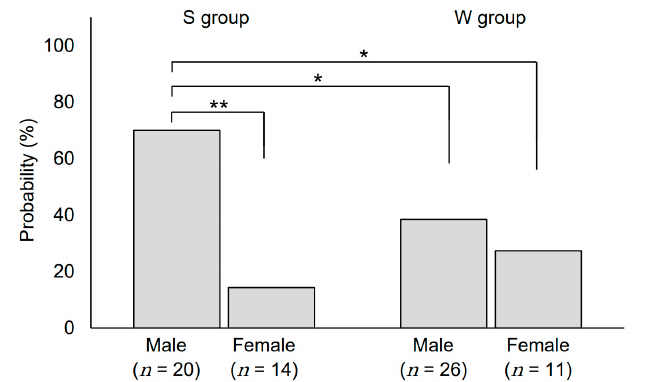
Figure 5. Incidence of grade 2 or higher acne-like rashes based on sex and season. Left, summer (S); right, winter (W). * p < 0.05, ** p < 0.01.